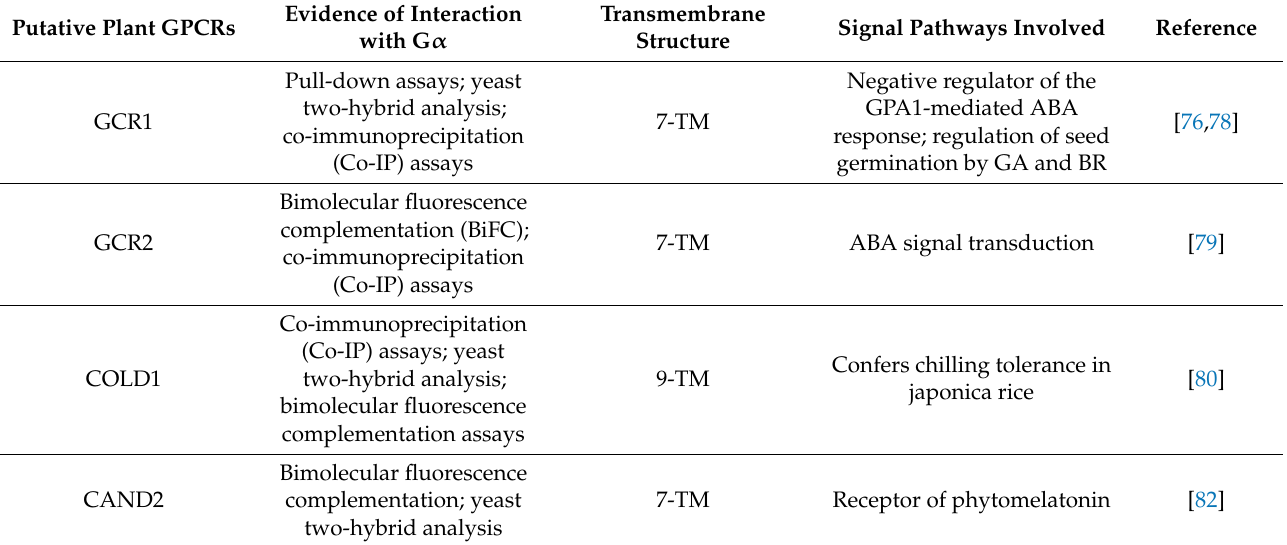
Table 2. Putative GPCRs in